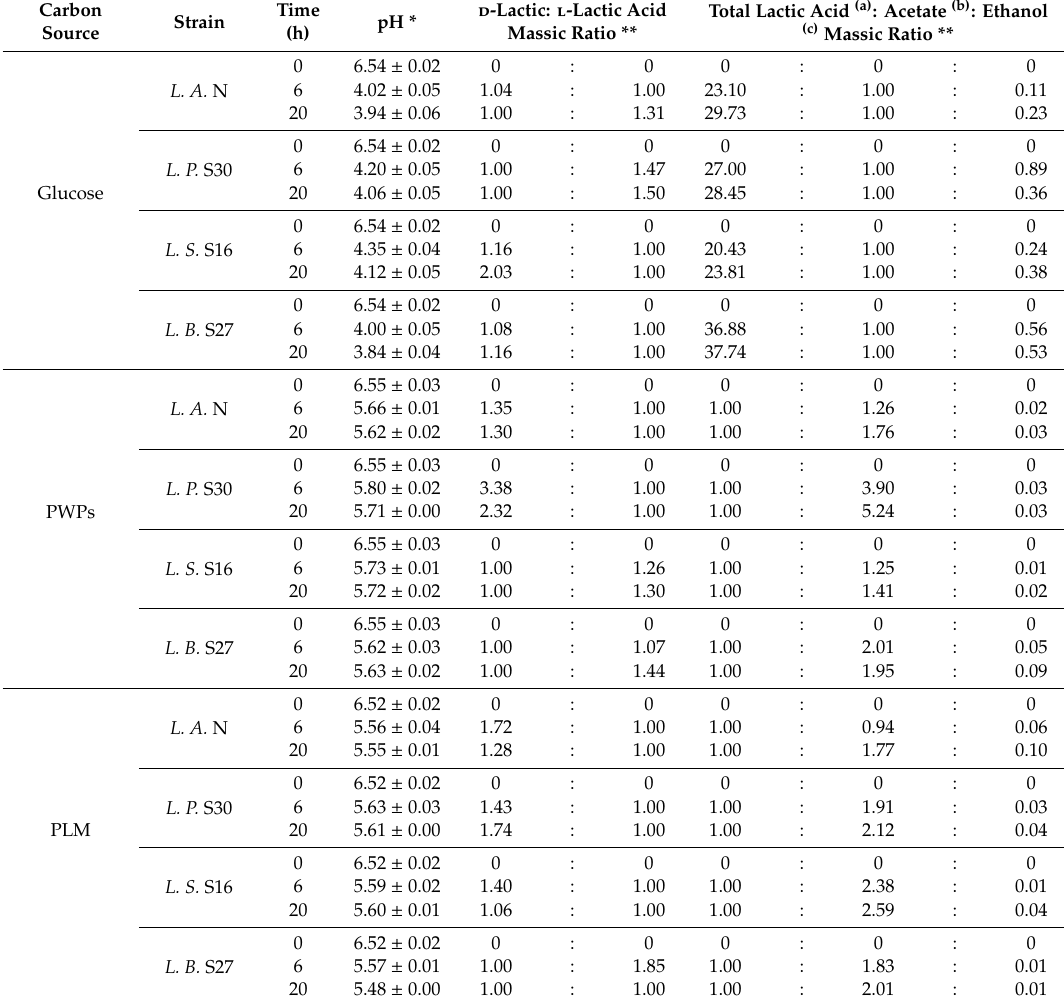
Table 3. Values of pH and ratios of lactic acid, acetic acid and ethanol production by L. acidophilus N ( L. A. N), L. plantarum S30 ( L. P. S30), L. sakei S16 ( L. S. S16) and L. brevis S27 ( L. B. S27) strains in the presence of glucose, PWPs and